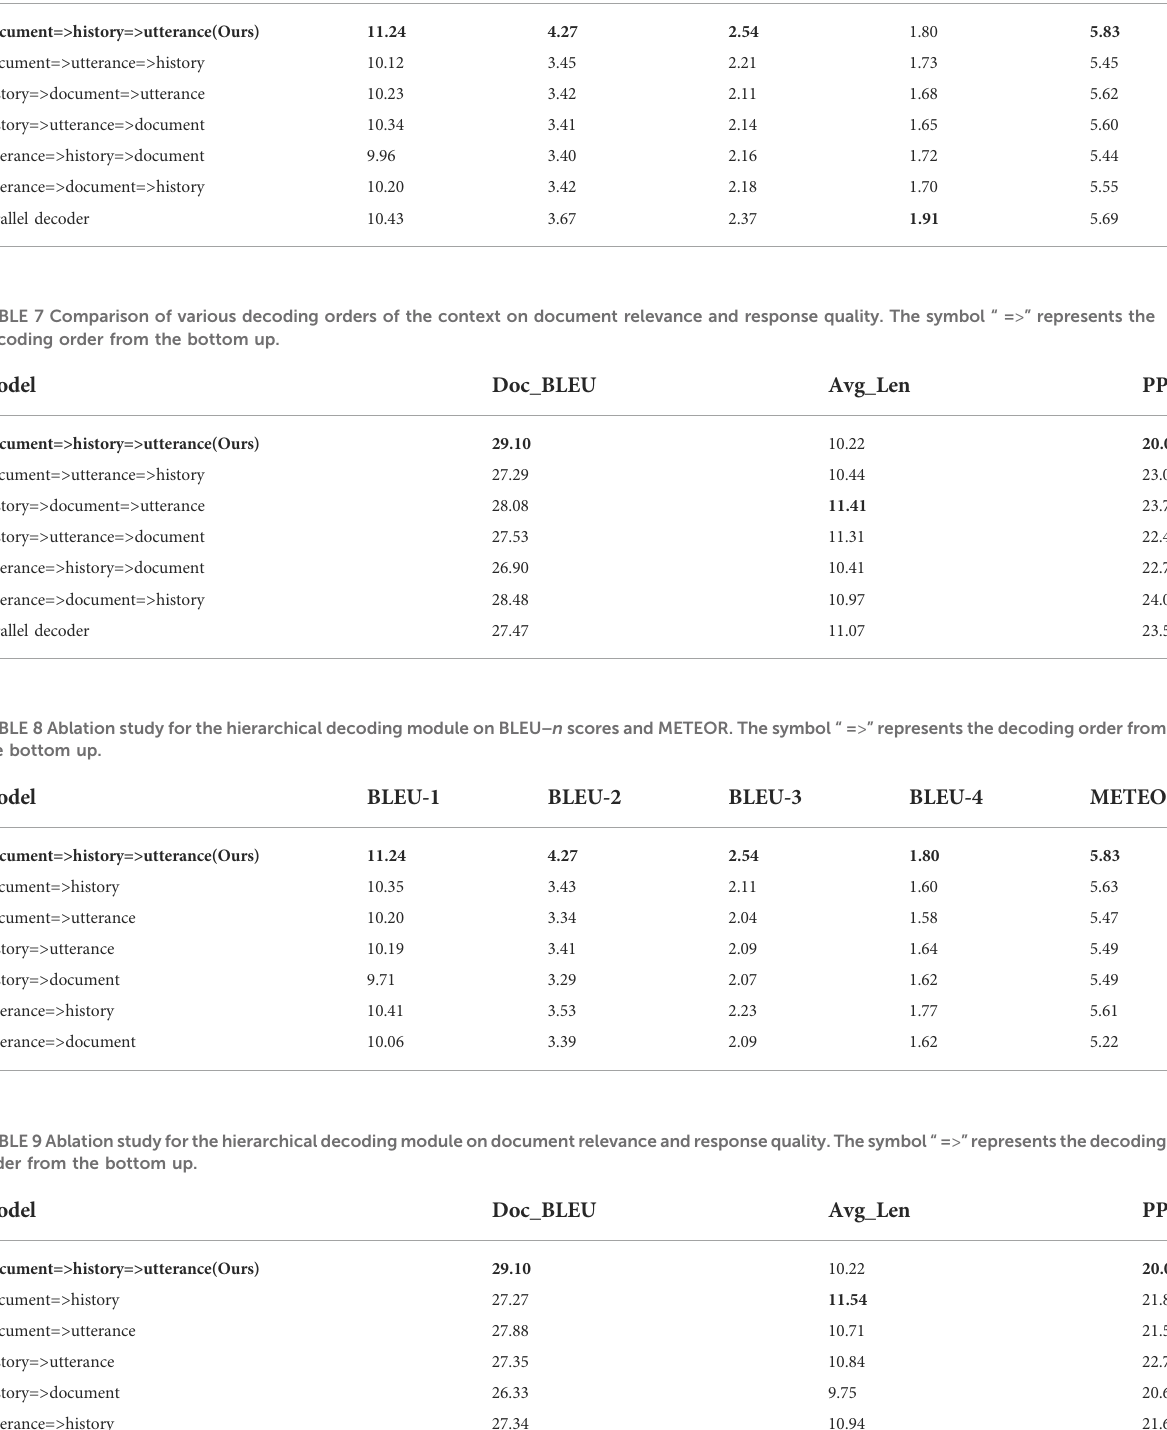
TABLE 6 Comparison of various decoding orders of the context on the BLEU − n score and METEOR. The symbol “ = > ” represents the decoding order from the bottom up. Model